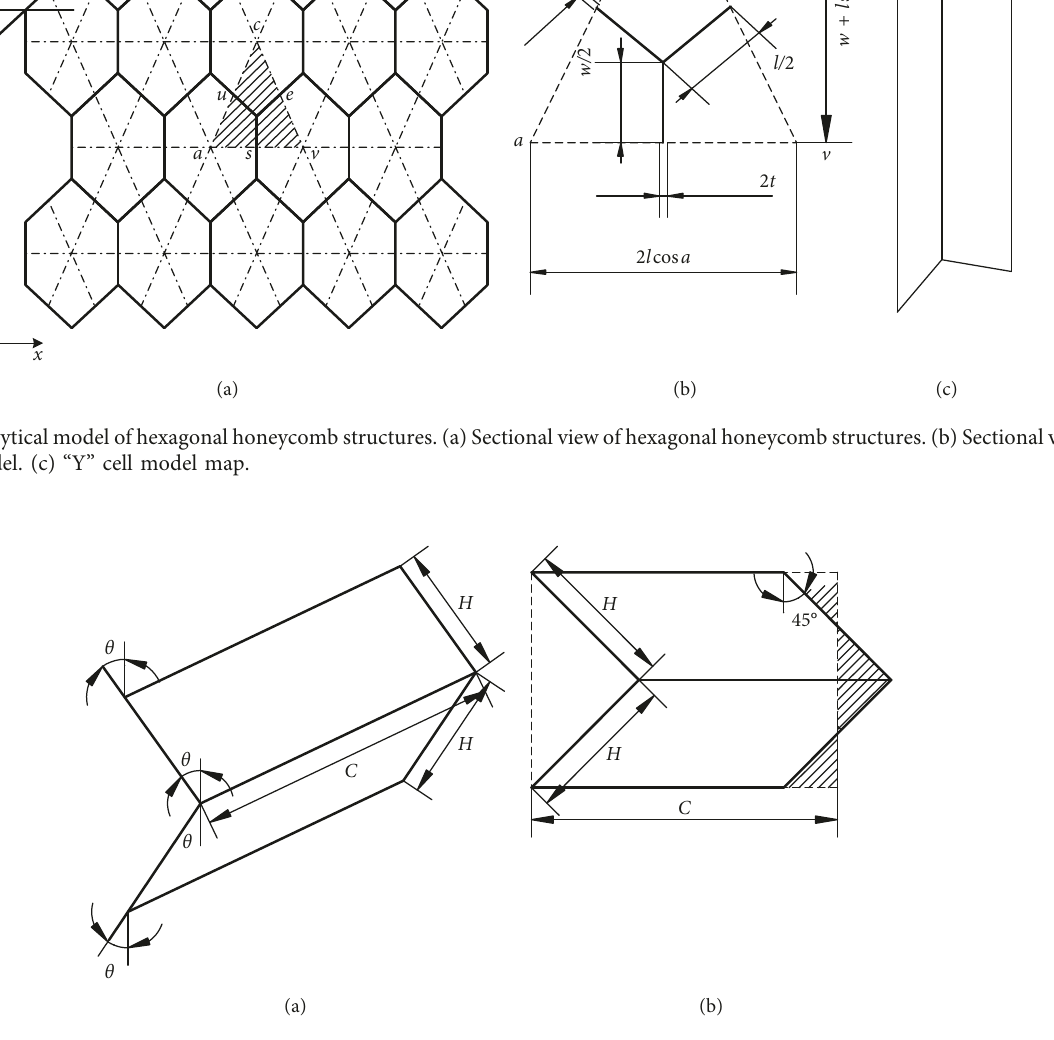
Figure 3: Simple super folding element model. (a) Bending absorption mode. (b) Deforming absorption